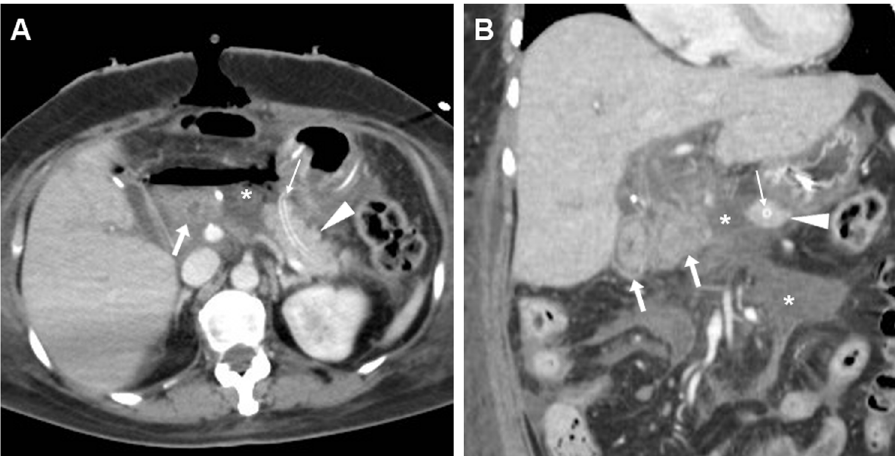
Fig. 6 a, b Dehiscence of the PJS with peritonitis in a 59-year-old woman with shock, sepsis and peritonitis 48 h after PD performed for a benign tumour of the Vaterian ampulla. CT showed discontinuity between the PR ( arrowheads ) with MPD stent ( thin arrows ) and MJL ( arrows ), filled by a large air-fluid collection (*) extending in the mesentery. Emergency relaparotomy was performed, with creation of a gastro- pancreatic anastomosis